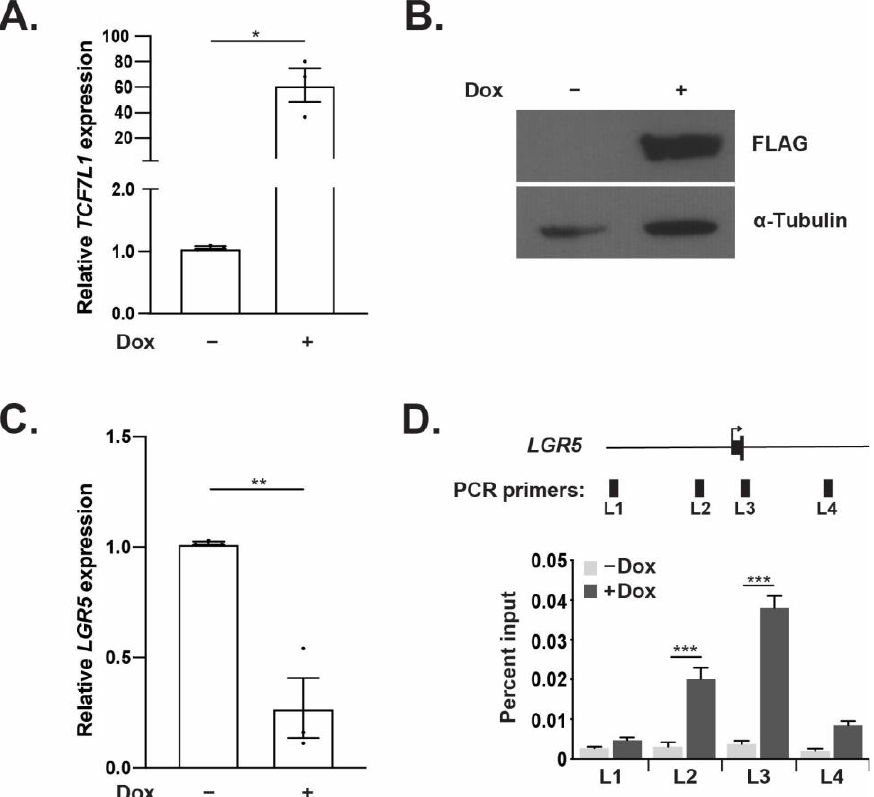
Figure 2. TCF7L1 represses LGR5 expression and directly binds to the LGR5 promoter region. ( A ) RT-qPCR and ( B ) Western blot analyses of TCF7L1 expression in untreated (−) or Dox-treated (+) FLAG-TCF7L1 HCT116 cells. ( C ) RT-qPCR analysis of LGR5 transcripts in FLAG-TCF7L1 HCT116 cells ± Dox. ( D ) Diagram of the LGR5 gene with the primer positions used for qPCR indicated by black rectangles. ChIP-qPCR analysis of anti-FLAG immunoprecipitated and purified DNA in FLAG-TCF7L1 cells ± Dox. Relative expression values are normalized to TUBB1. ChIP data are presented as percent of input. Error bars represent SEM (* p < 0.05, ** p < 0.01 , *** p < 0.001).